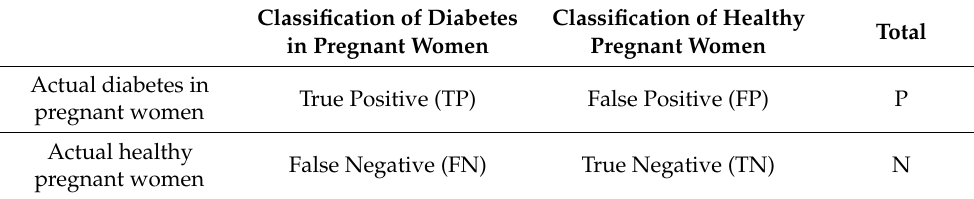
Table 7. Classification matrix elements of the PIDD. Classification of Diabetes